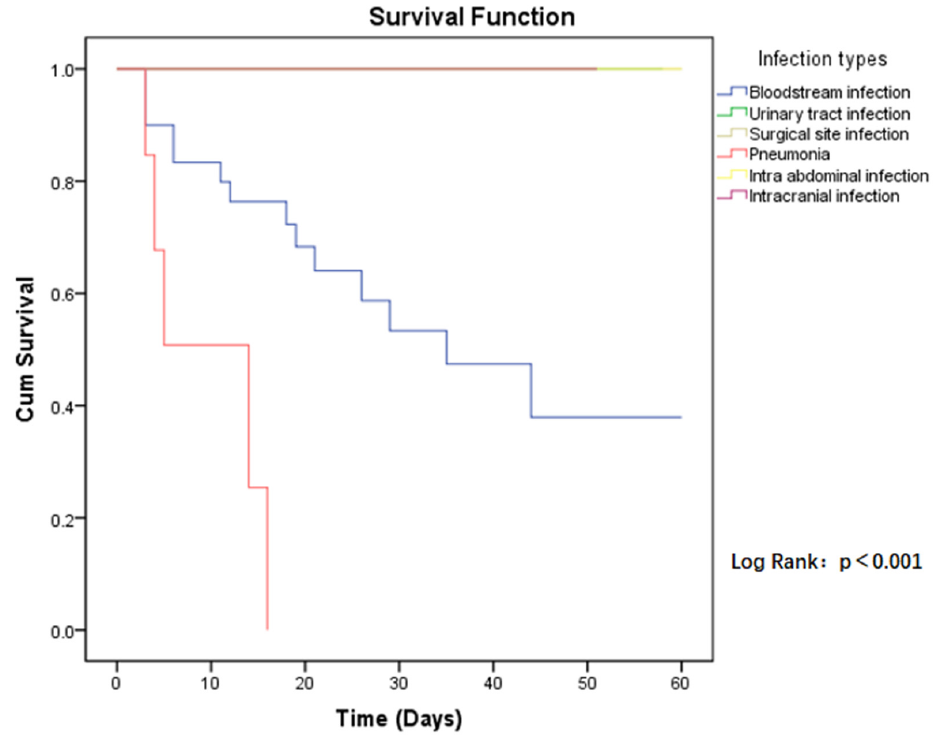
Figure 2. Kaplan–Meier estimates (and 95% confidence limits) of the survival probability of infection types in CP-CRE infections, 60-day follow up.